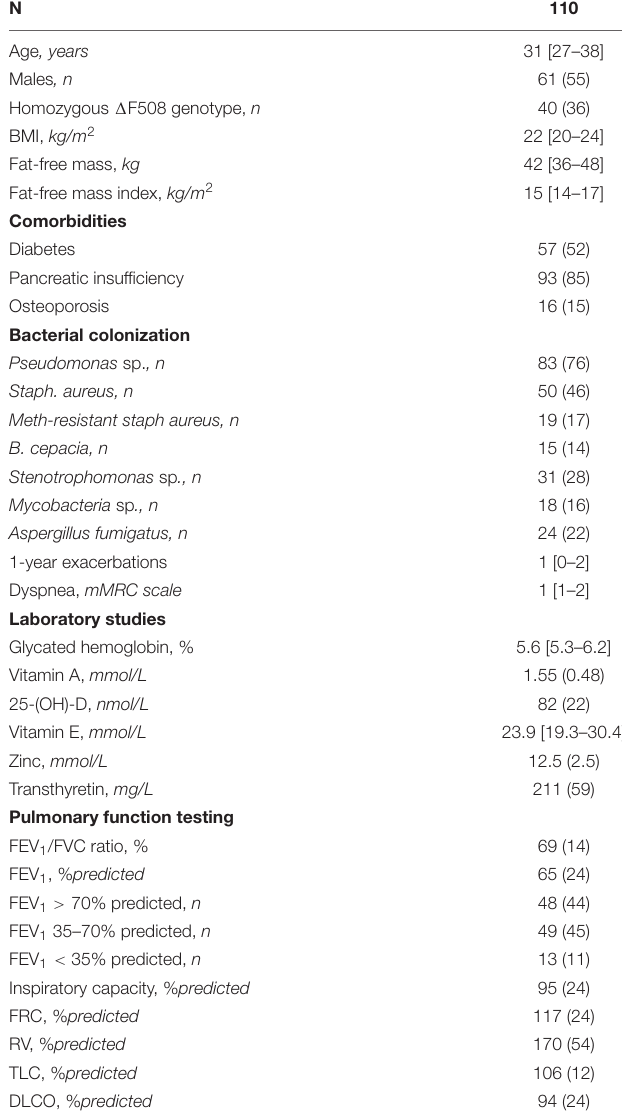
TABLE 1 | Patients characteristics